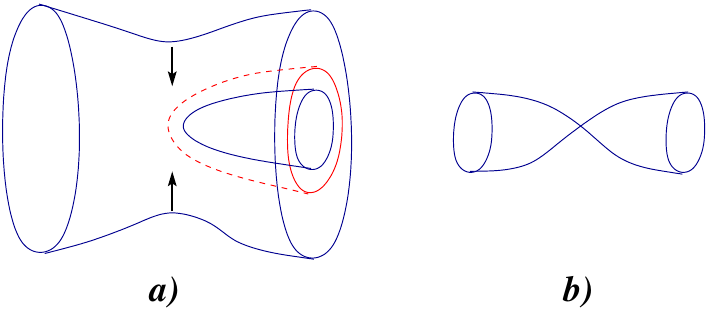
Figure 9 . In the limit, a deformation of the system of positive and negative branes (a) gives the Seiberg-Witten curve (b). Solid blue lines represent positive branes, while dashed red stands for negative